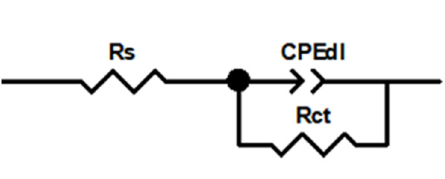
Figure 18. Equivalent circuit for the Nyquist plots analysis. Table 6. The equivalent circuit parameters and fitting results of the impedance spectra of the Ni-W Figure 17. Electrochemical impedance spectra for the Ni-W and Ni-W/SiC coatings on 45 steel sub- and Ni-W/SiC coatings pretreated by two different processes. strates subjected to two different pretreatments in 3.5 NaCl: ( a ) Nyquist plots; ( b ) Bode plots.